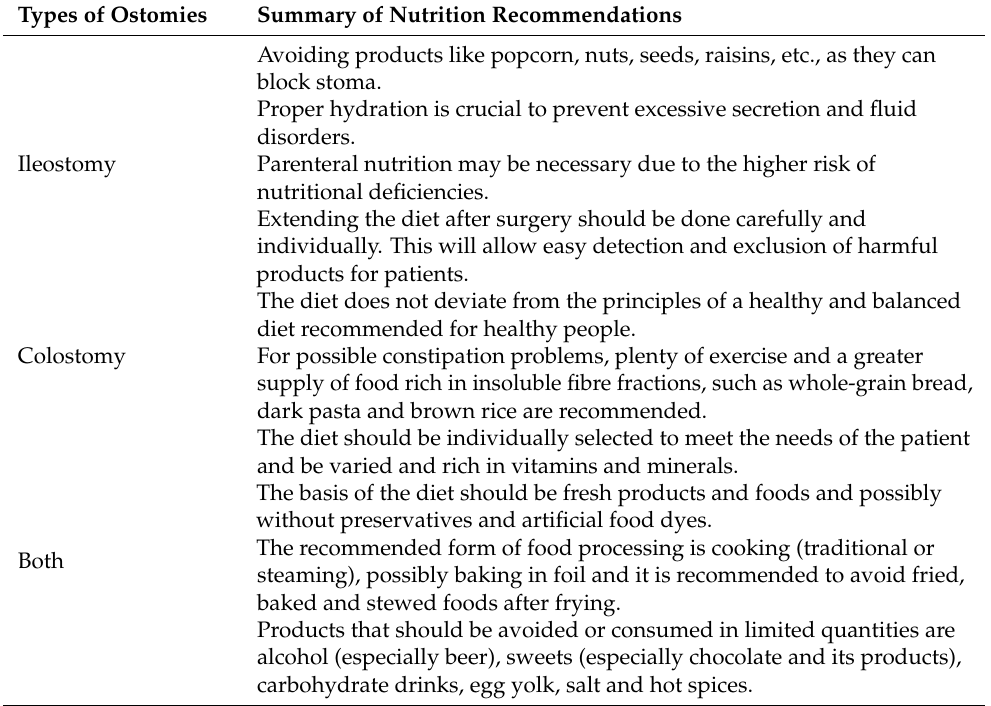
Table 2. Summary of nutritional recommendations for patients with ostomies. Types of Ostomies Summary of Nutrition